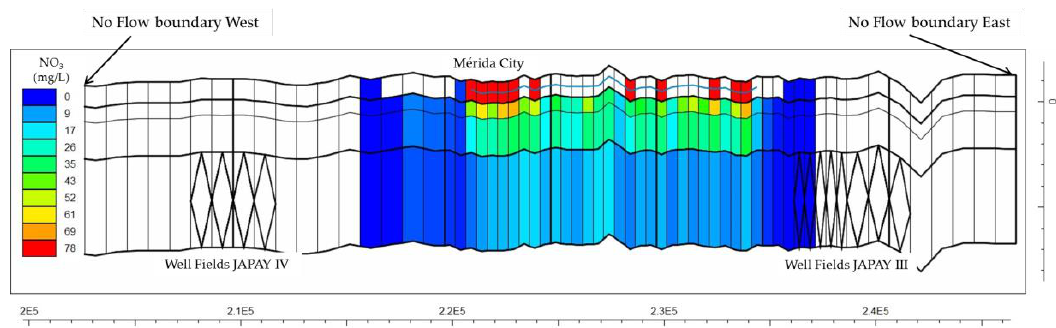
Figure 6. Pollution plume simulation after 60 years. The pollution plume follows the groundwater flow, moving towards the coast, indicating the vulnerability of towns located in the middle.